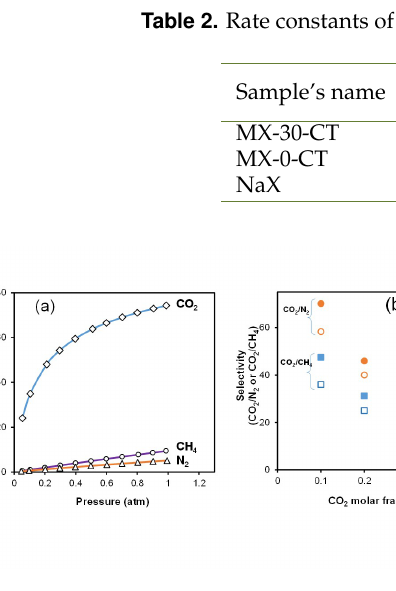
Fig. 7. a) Regeneration of samples at various time 30-minute